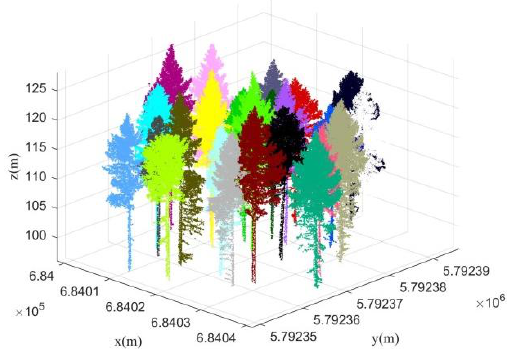
Figure 5 . The reference separated individual trees. Each individual tree is randomly